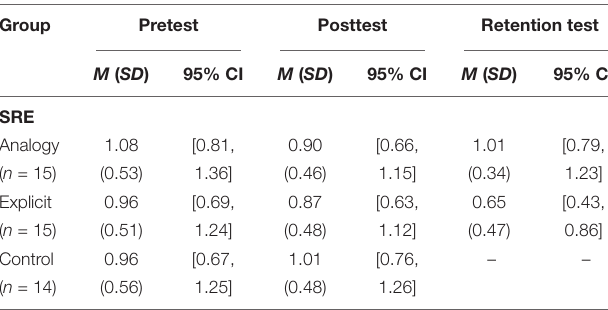
TABLE 3 | Descriptive statistics for SRE in meters across the pretest, posttest, and retention test for the three groups. Group